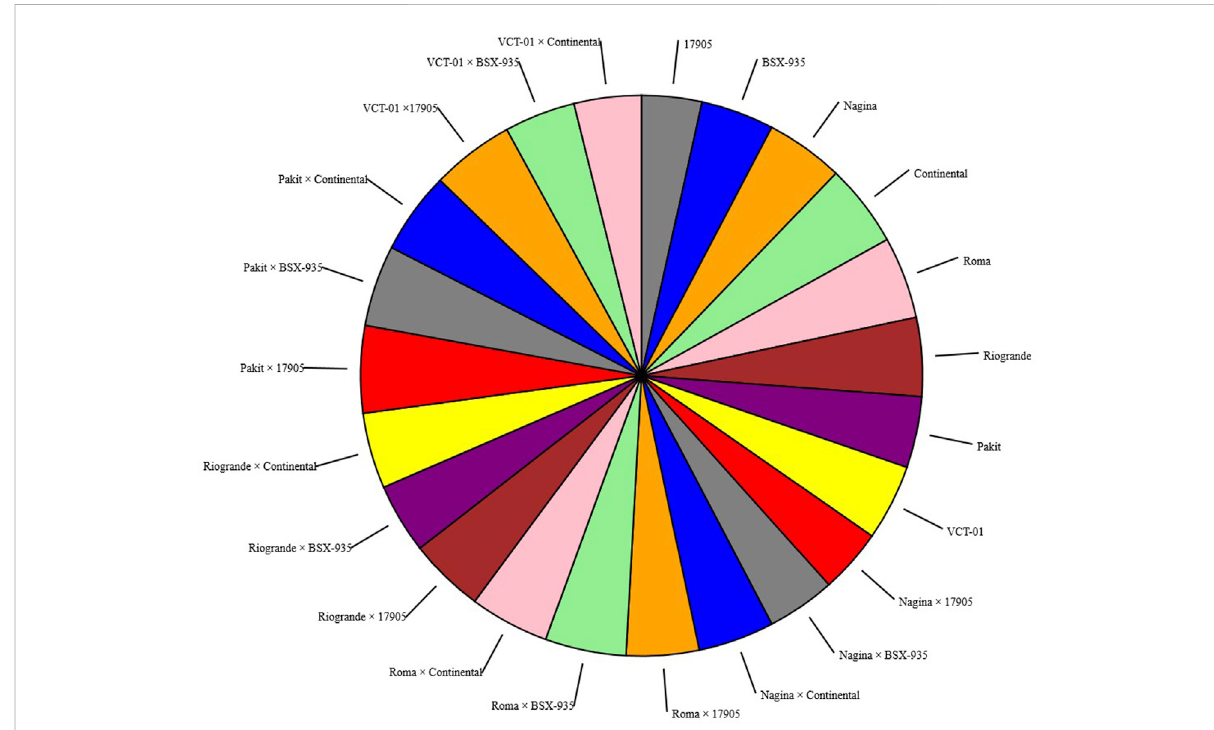
FIGURE 1 Pie chart represents the size of the value of DM (50%) for each parent and hybrid. Each segment in the pie chart represents a